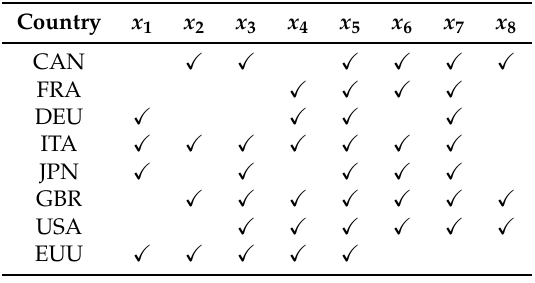
Table 3. Importance of the eight variables on Model (1) for each country. Country x 1